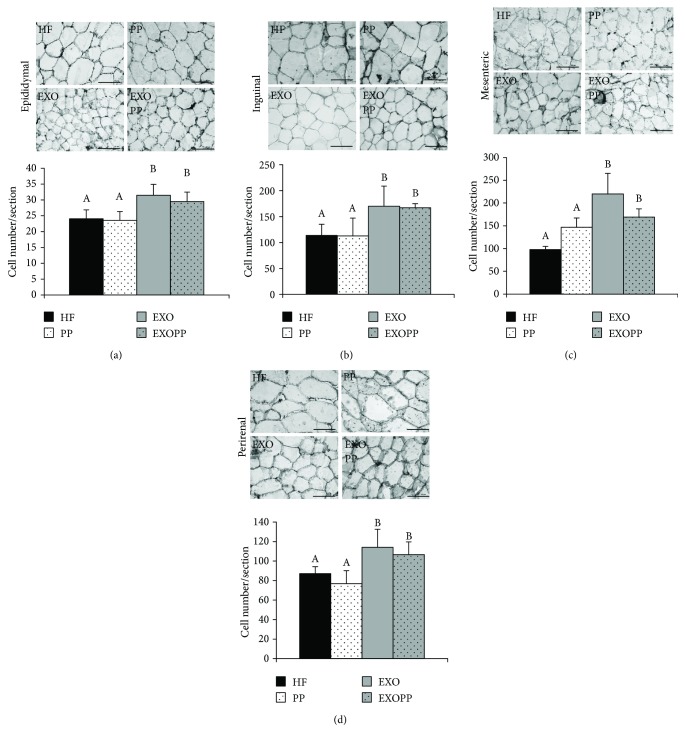
Effect of exercise training and polyphenol supplementation on adipose tissue. Representative sections of epididymal (a), inguinal (b), mesenteric (c), and perirenal (d) adipose tissues stained with hematoxylin and eosin are shown. Relative cell size was expressed as adipocyte count per section. An increase in adipocyte count per section is related to a decrease in adipocyte size. Data are expressed as mean ± SEM with n = 8–10 rats per group. Bars not sharing a common letter are significantly different at p < 0.05.